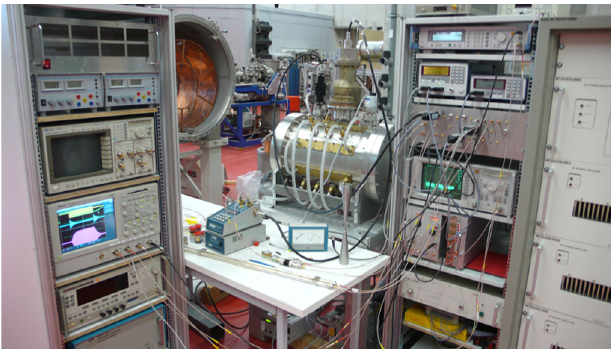
FIG. 19. The experimental setup for the high power test. The cooling system of the cavity can be clearly